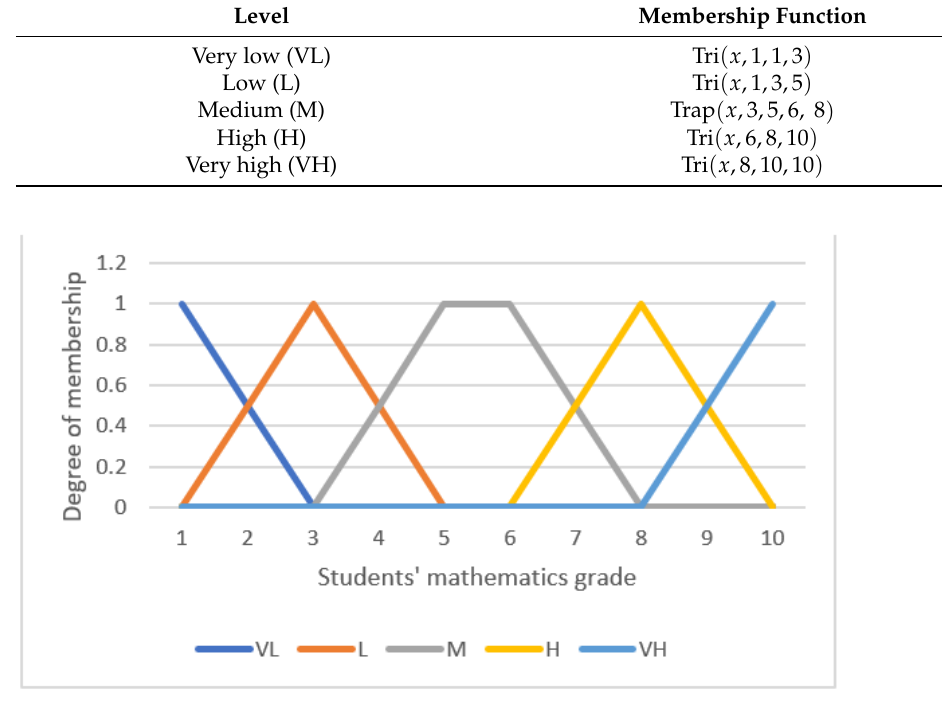
Figure 4. Plots of the membership functions for the fuzzification of crisp grades.